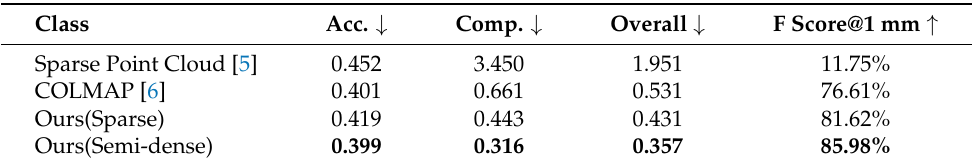
Table 8. Comparison between traditional methods on the DTU dataset (lower is better). The best results are in